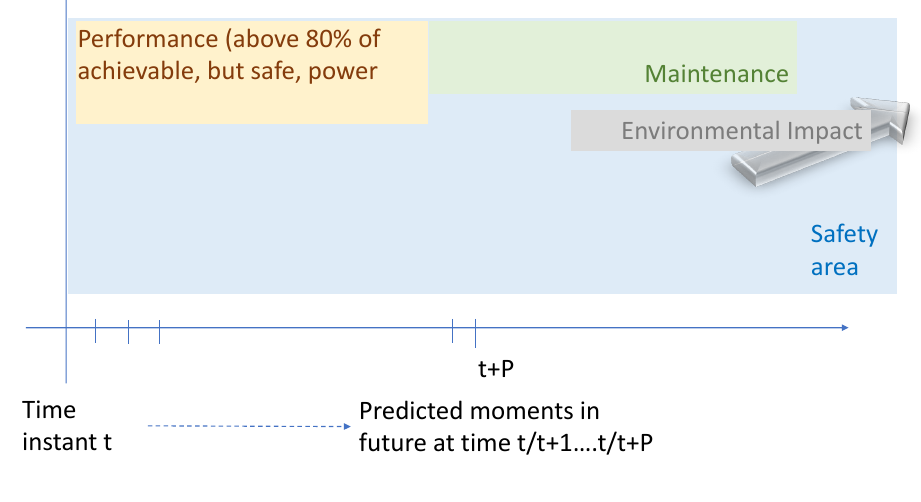
Figure 5. Illustration of the multiple objectives as a function of time and operation range percentage .